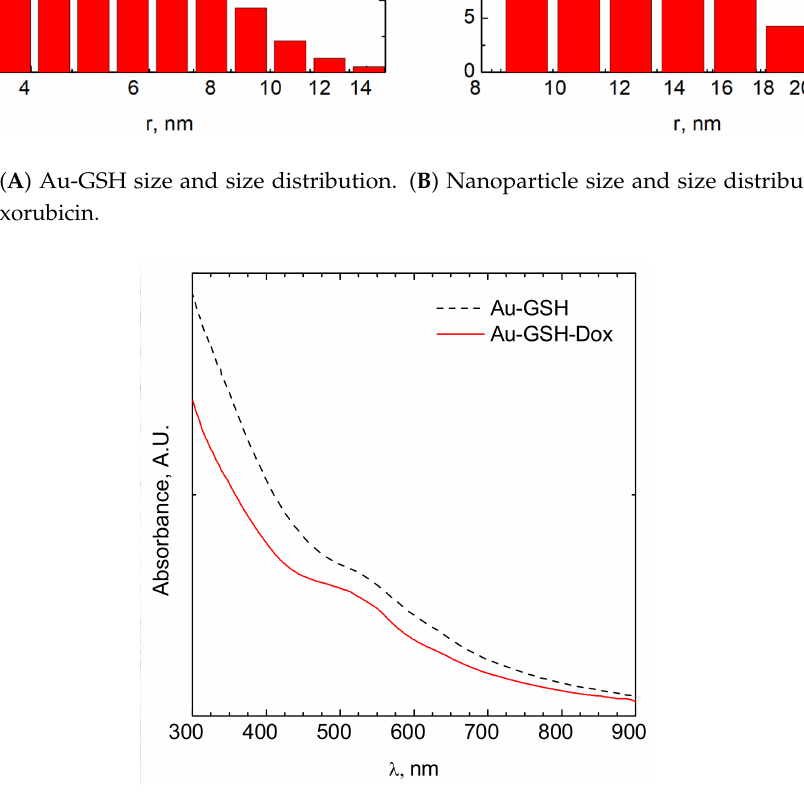
Figure 2. UV-Vis spectrum of a colloidal suspension of gold nanoparticles modified by glutathione (black dotted line) and doxorubicin (red solid